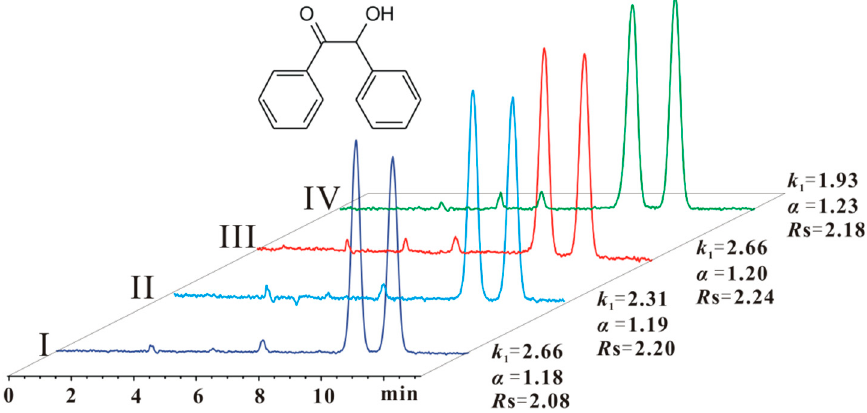
Figure 5. Enantioseparation of compound 3 (benzoin) on CSP 5 under different conditions. The